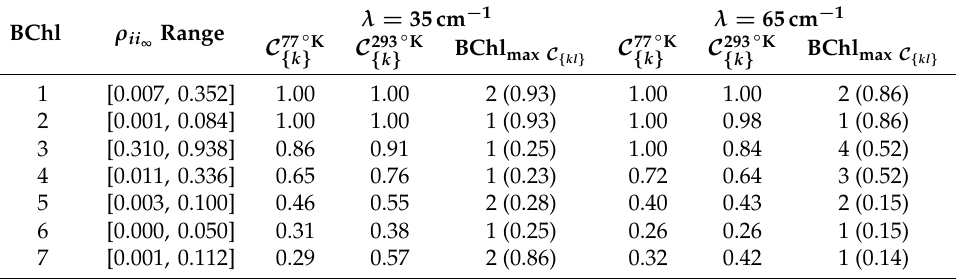
Table 1. Summary of some operative values for each BChl through the parametric analysis for γ = 50cm − 1 with λ = 35cm − 1 , and λ = 65cm − 1 ρ ii ∞